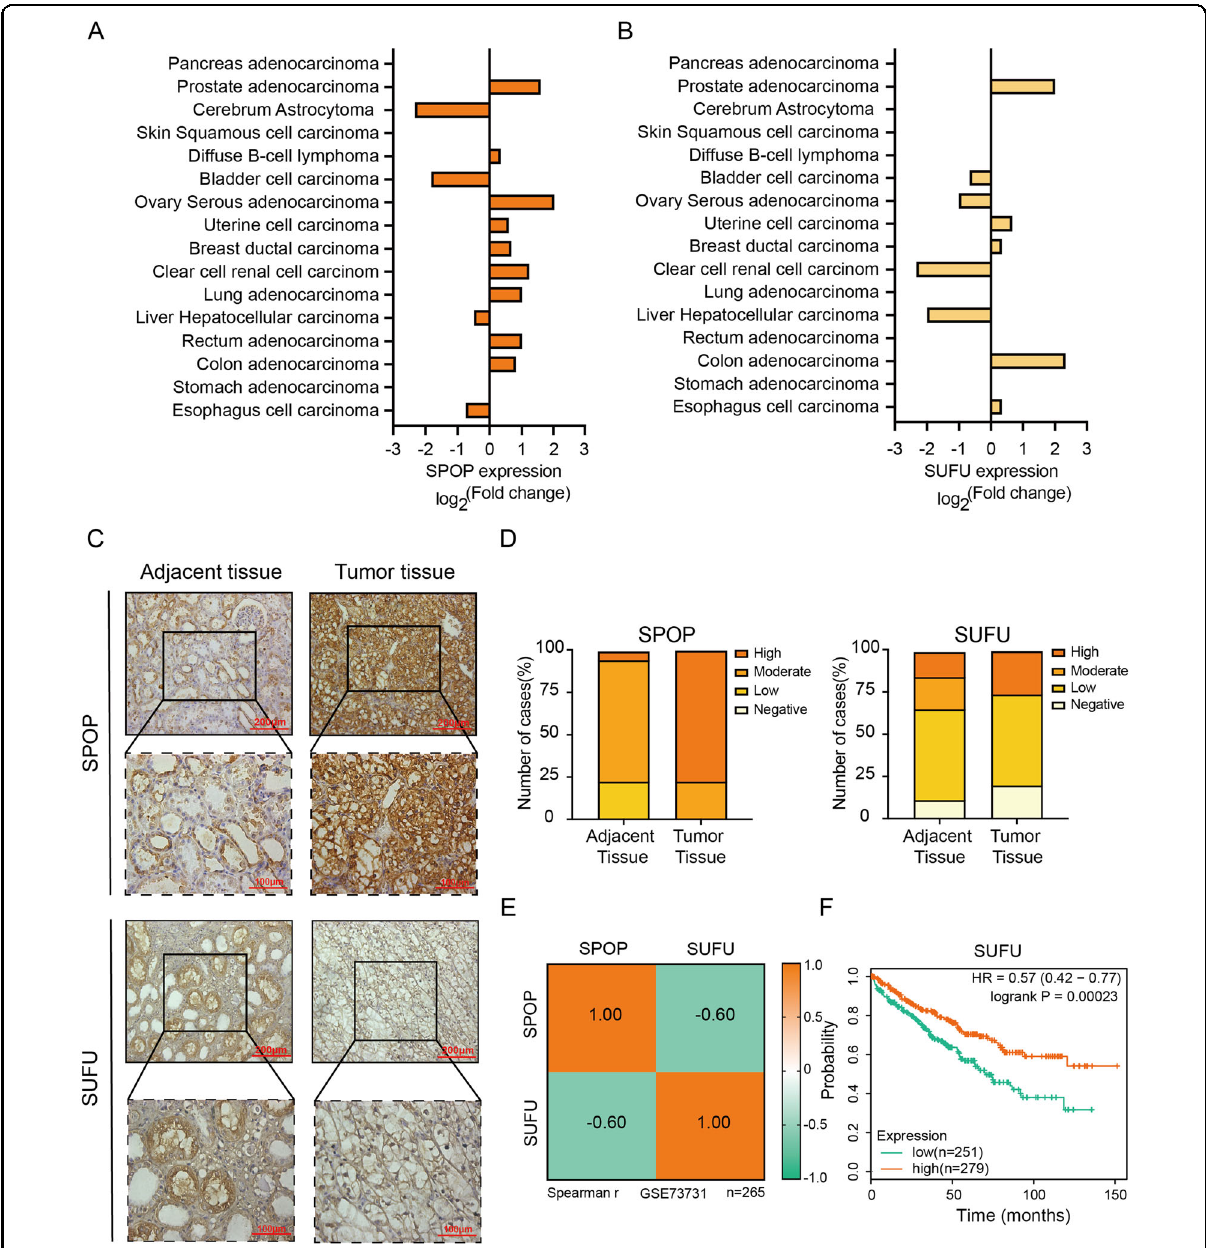
Fig. 4 SPOP is negatively correlated with SUFU in ccRCC. A , B The statistical results for IHC staining of SPOP and SUFU among 16 different cancer types in human tissue microarrays. C , D Representative IHC staining for SPOP and SUFU in ccRCC tissues and normal adjacent tissues. E Spearman correlation analysis indicated that the mRNA level of SUFU was also negatively correlated with SPOP in ccRCC in GEO database (GSE73731). F Kaplan – Meier survival analysis of overall survival rate of ccRCC patients with high or low SUFU mRNA expression performed by using a dataset from Kaplan – Meier